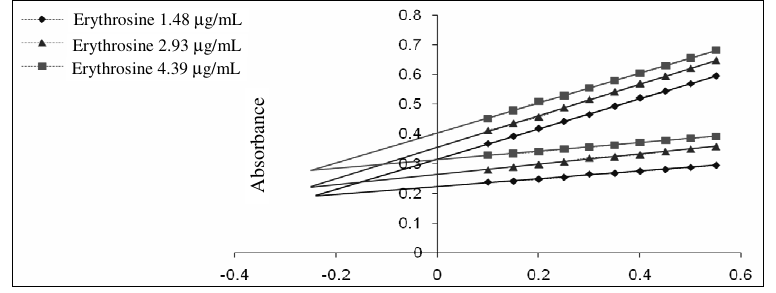
Figure 5. Plot of H -point standard addition method for simultaneous determination of fixed amounts of eosin concentration (3.12 µ g/mL) and different amounts of erythrosine, when different standard eosin solutions are